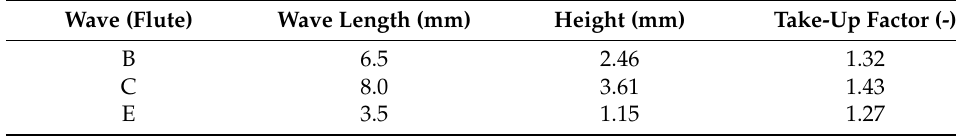
Table 2. Geometric parameters of waves.